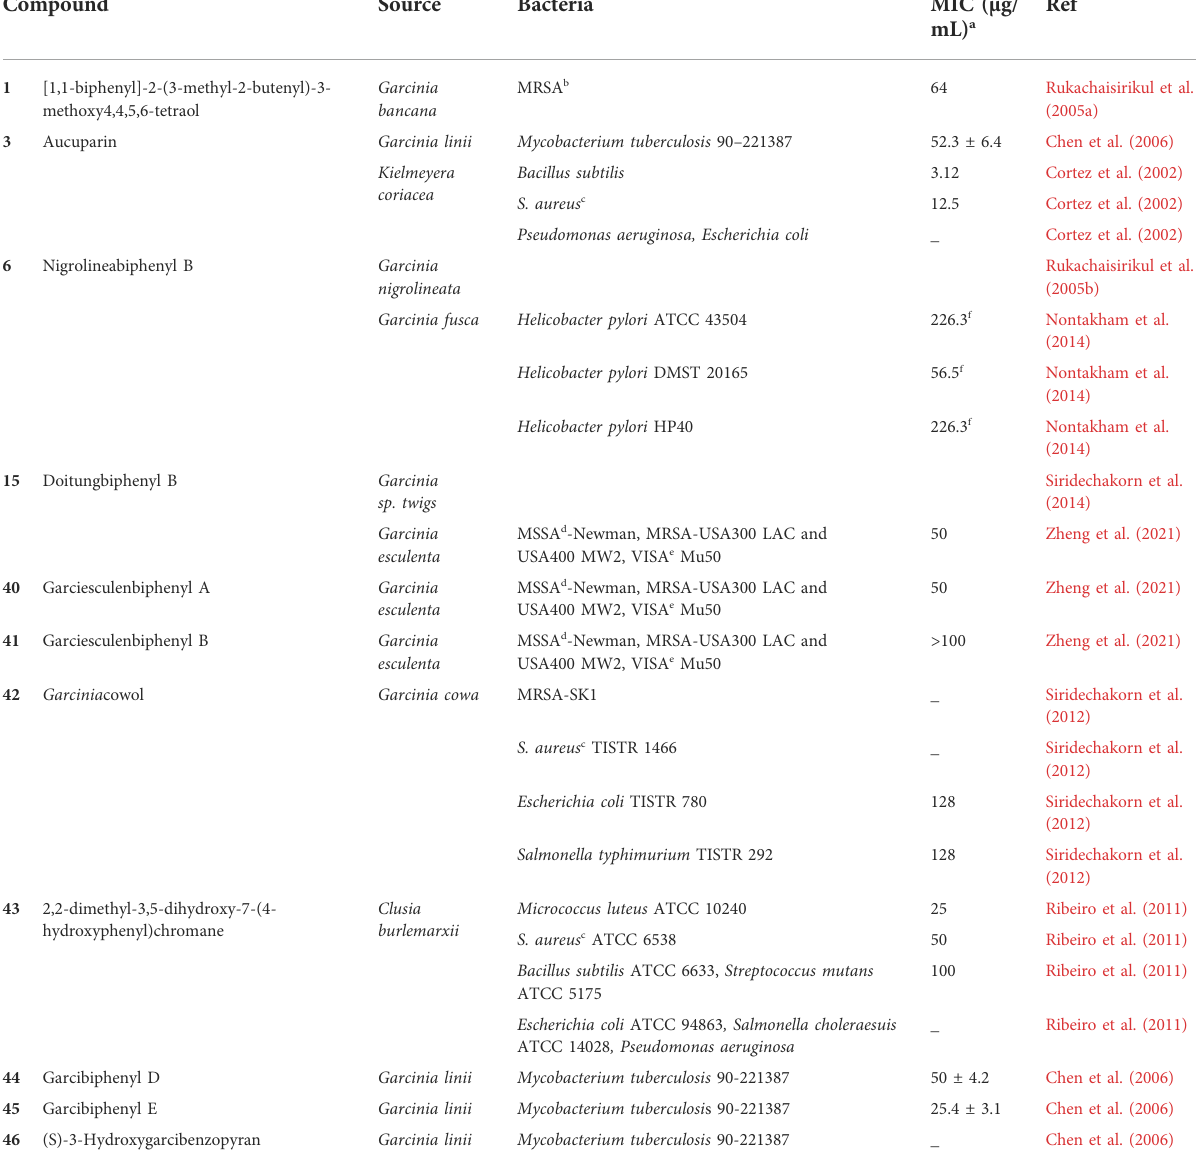
TABLE 2 Biphenyls from Clusiaceae and associated antibacterial